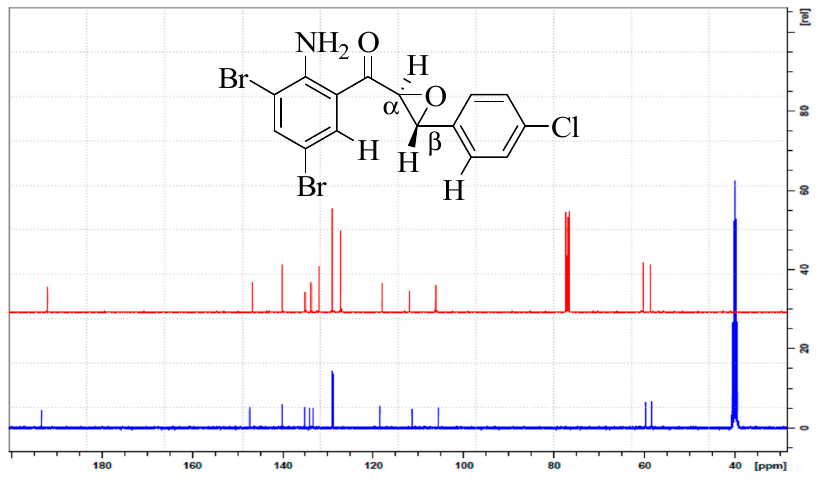
Figure 3. 13 C-NMR spectra of 2c in CDCl 3 (red) and DMSO- d 6 (blue) at 100 MHz.